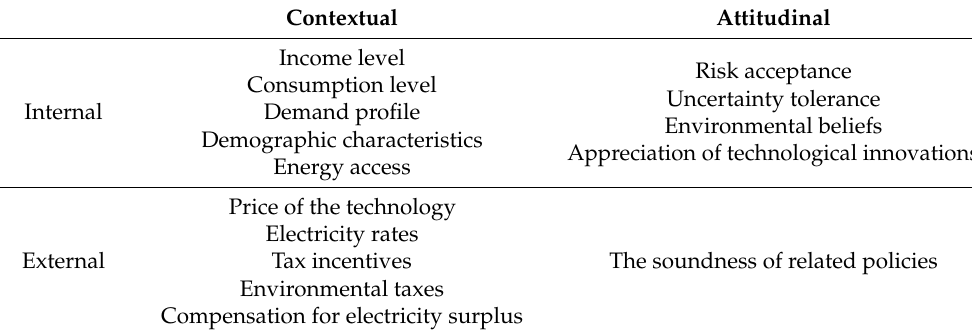
Table 1. Classification of factors that influence the decision-making of prosumers in self-consumption